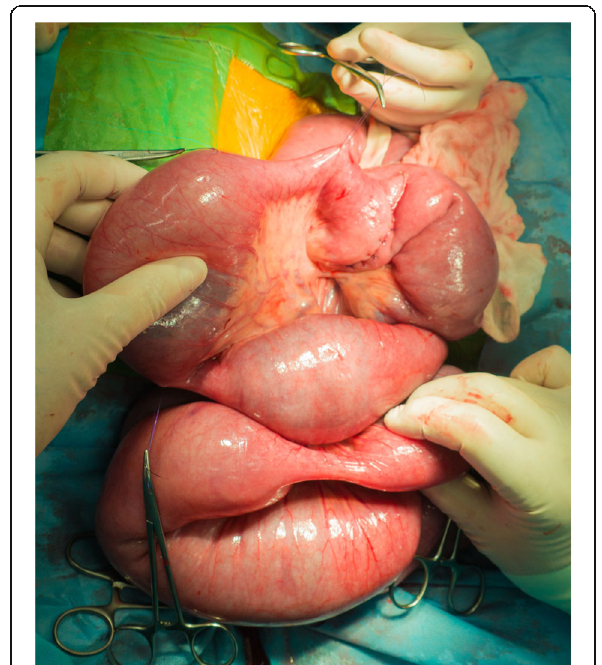
Fig. 1 Intraoperative view: two stenotic segments of small intestine and side-to-side anastomosis completing intestinal resection